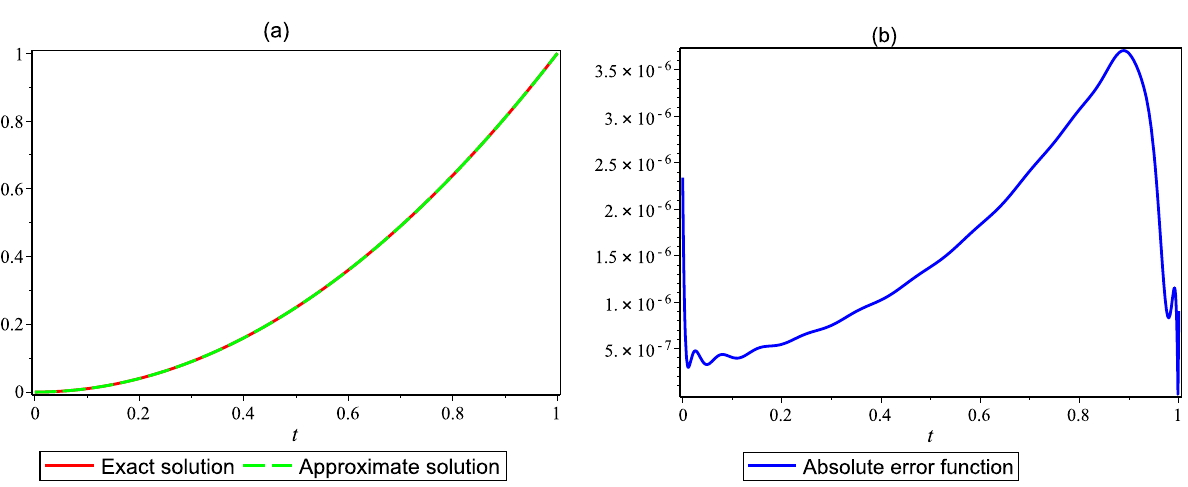
Figure 1. MAEs for different values of N for Example 1.